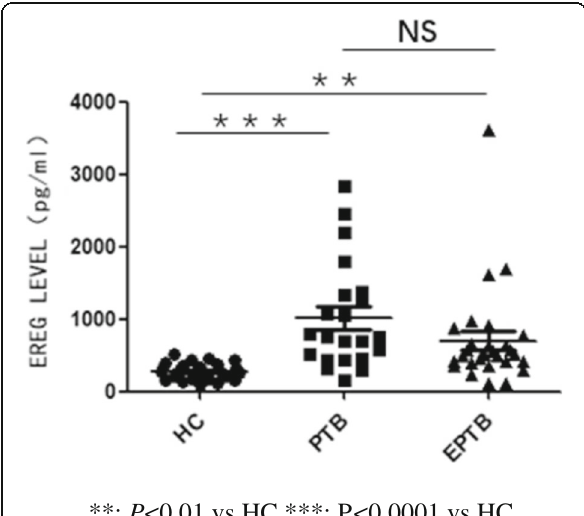
Fig. 1 The EREG level were measured by ELISA kit. HC: healthy controls PTB: pulmonary tuberculosis EPTB: extra-pulmonary tuberculosis. **: P < 0.01 vs HC ***: P < 0.0001 vs HC